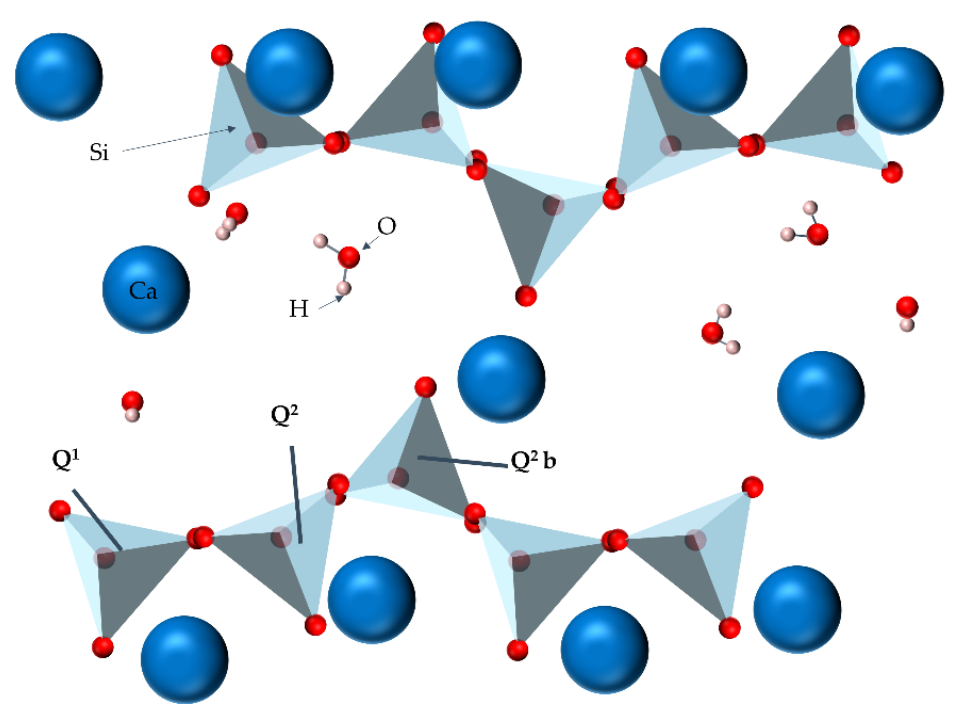
Figure 1. The bonding mode of Si element in C-S-H gel.